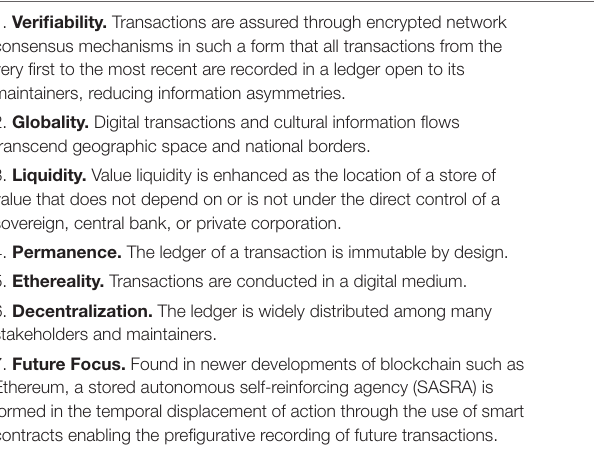
transaction rather than trusting a bank or other intermediary. TABLE 1 | Seven tendencies of blockchain